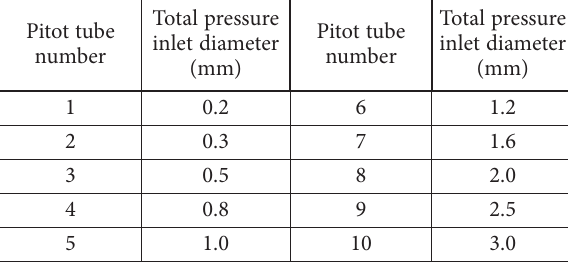
Table 1. Pitot tube hole